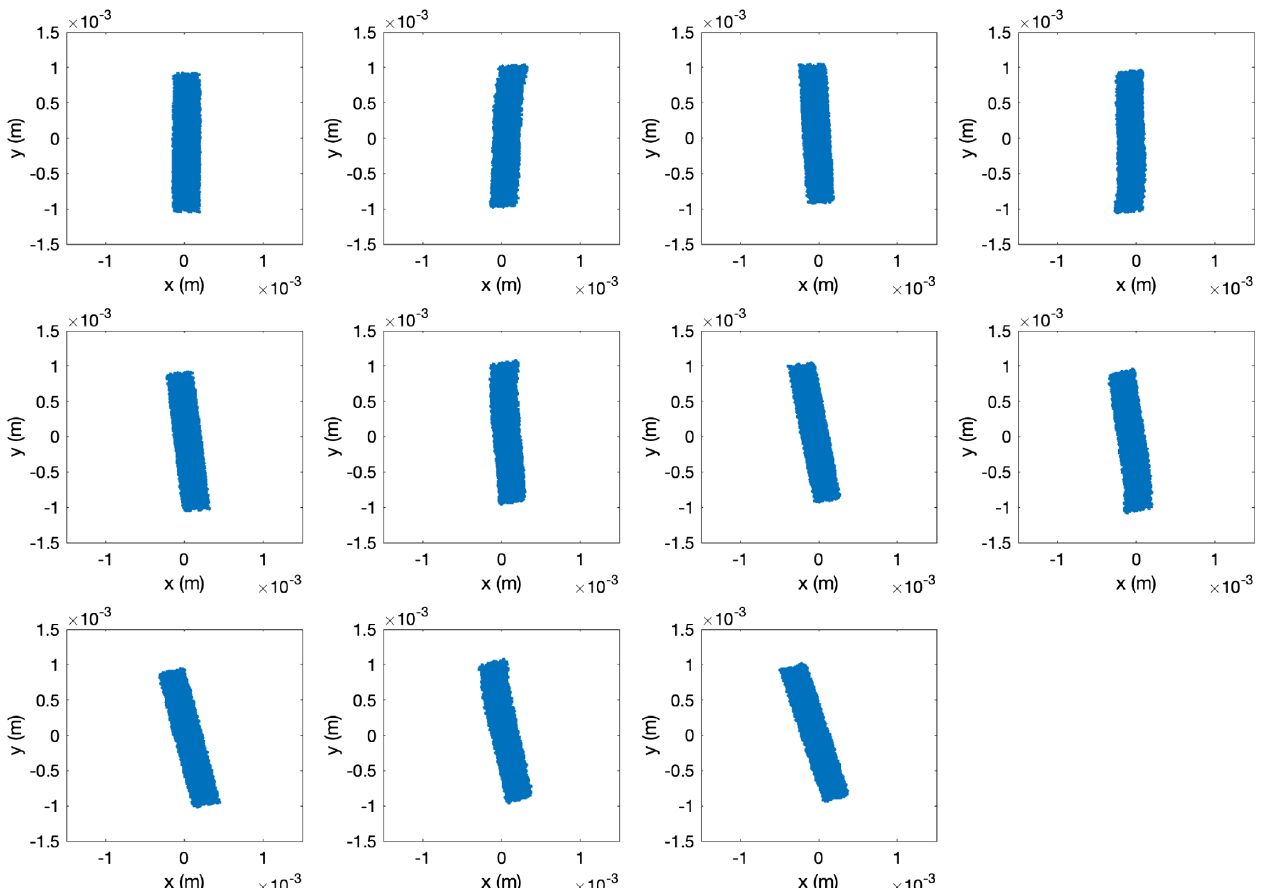
FIG. 15. The evolution of flat beam profiles at the cooler over 11